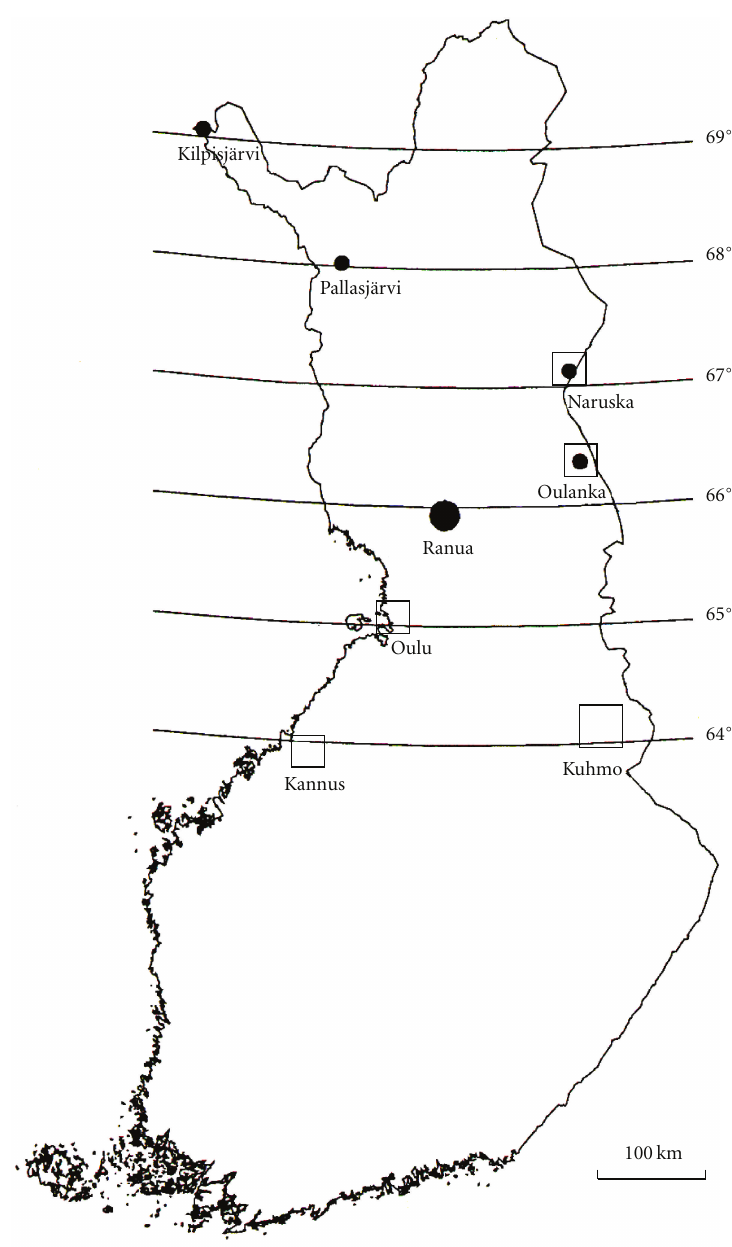
Figure 1: Map of transplantations for the ecotypes Kuhmo ( (cid:2) ) and Ranua ( •